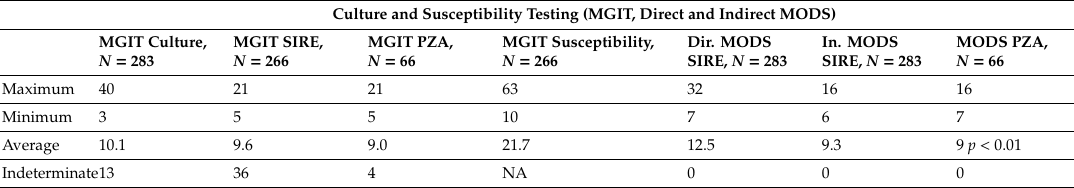
Table 1. Time taken (in days) for culture and susceptibility